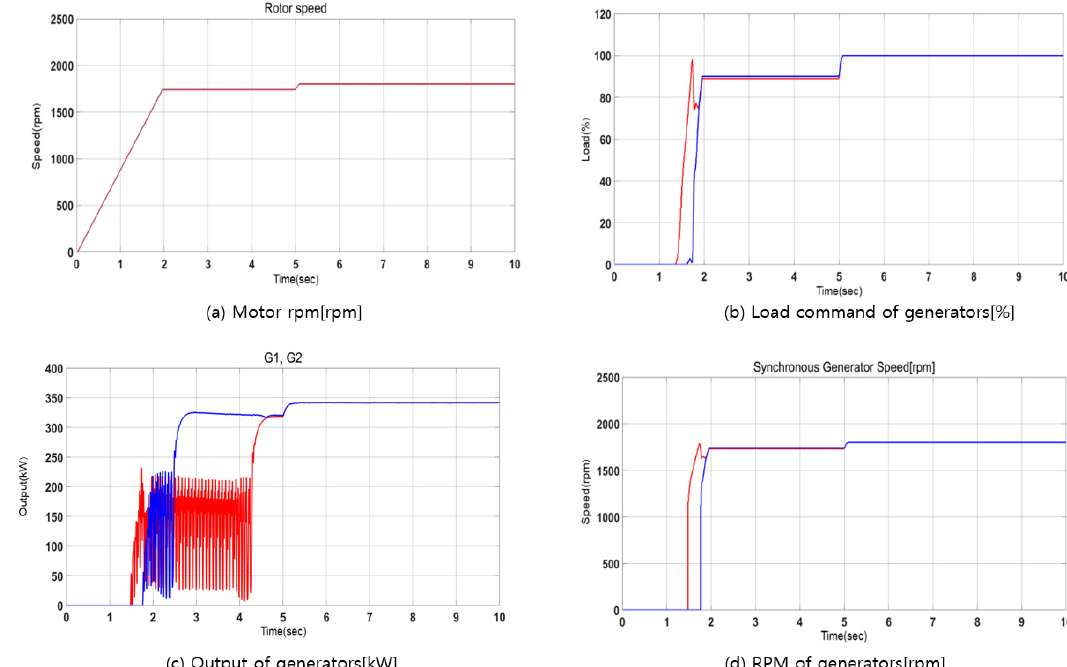
Figure 24. Simulation results of propulsion motor and generators when load varies as 90 → 100%.